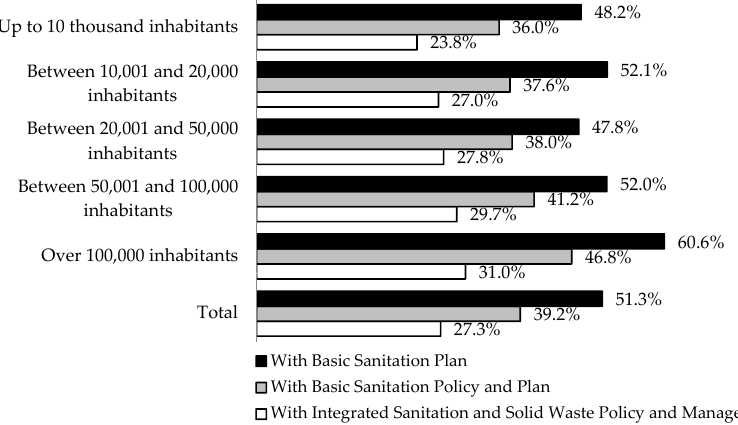
Figure 8. Management context of local and regional basic sanitation companies in Brazil in 2016. Source: Authors’ own elaboration from the NSIS